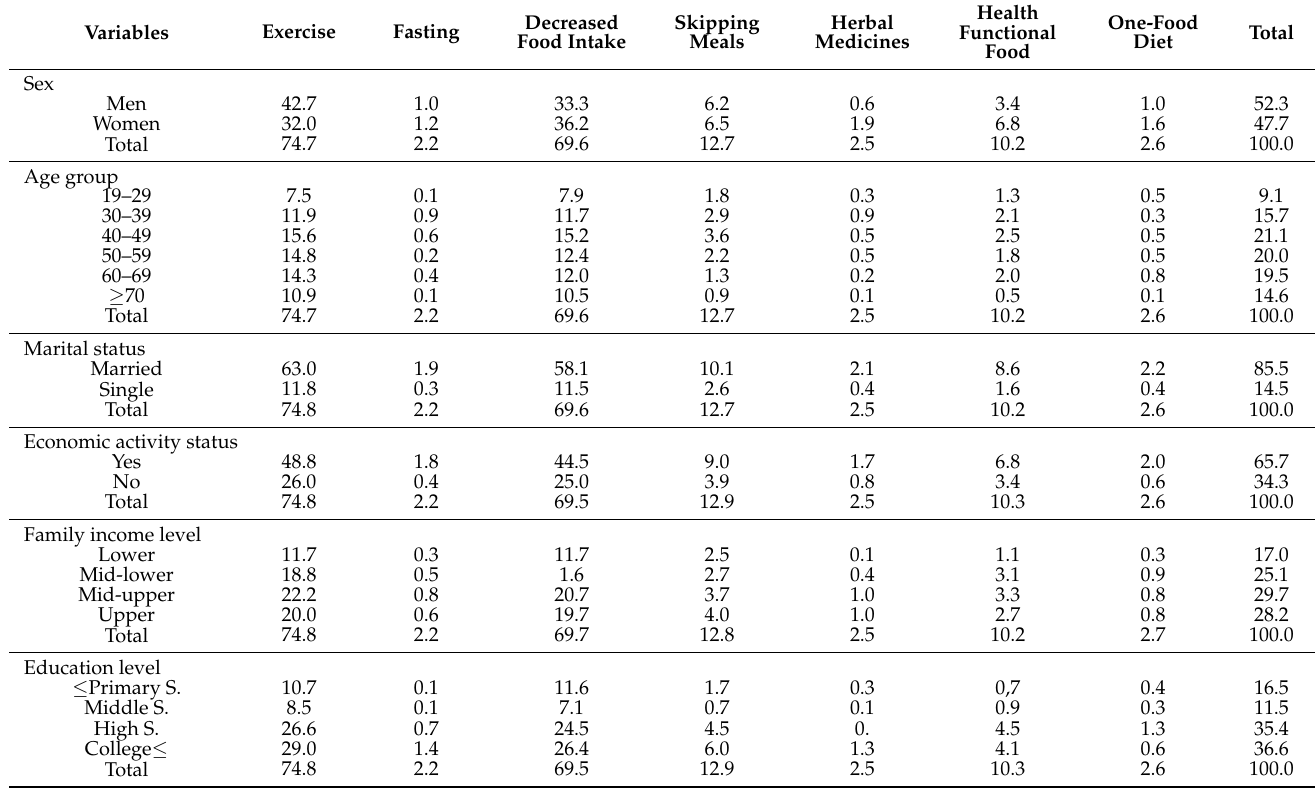
Table 3. CIHA for weight management according to general characteristics in the Korean obese population ( ≥ 19 years old). Variables